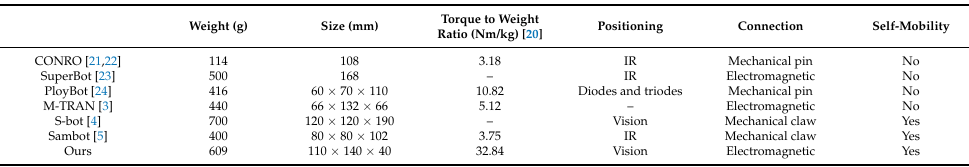
Table 4. Comparison of reconfigurable modular robots.